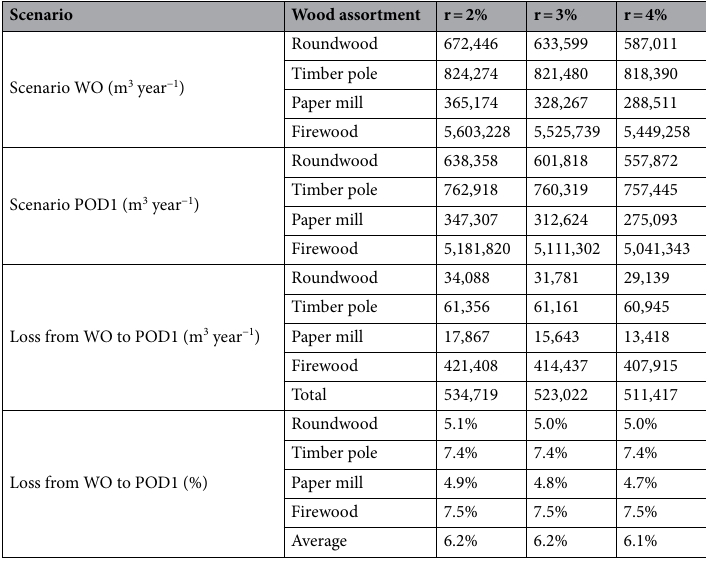
Scenario Wood assortment r = 2% r =